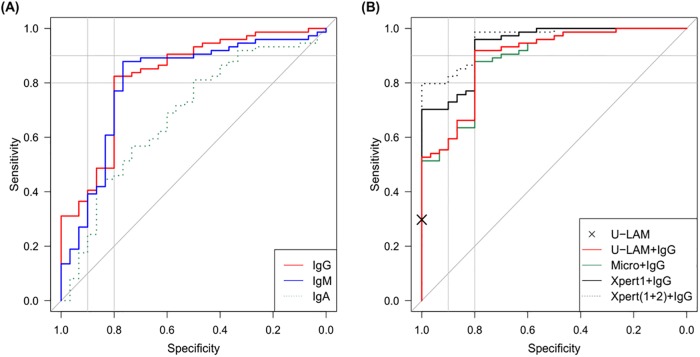
Receiver operation characteristic (ROC) curves for detection of TB with M. tuberculosis culture as reference gold standard.(A) IgG, IgM, and IgA to AM; (B) IgG to AM combined with other rapid diagnostic tests. ROC curves include cross-validation.